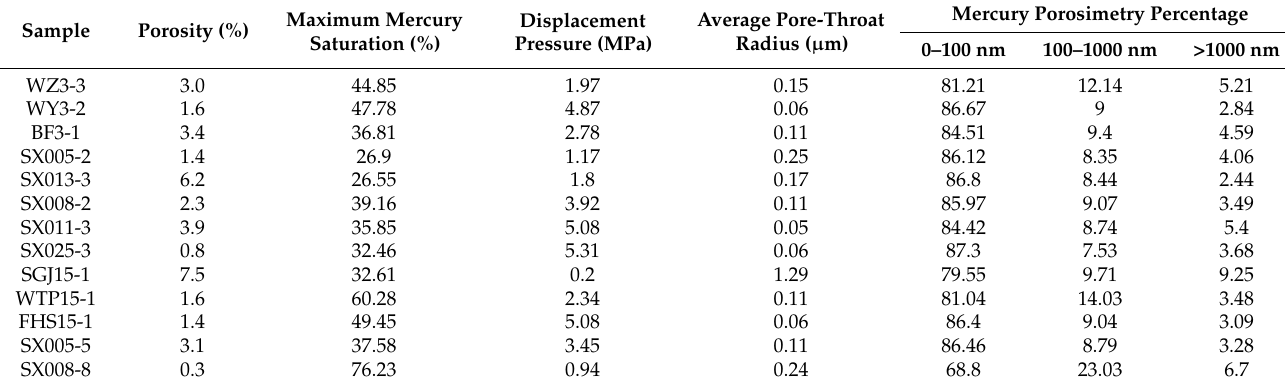
Table 3. Mercury injection data of coal reservoir samples in the south of Qinshui